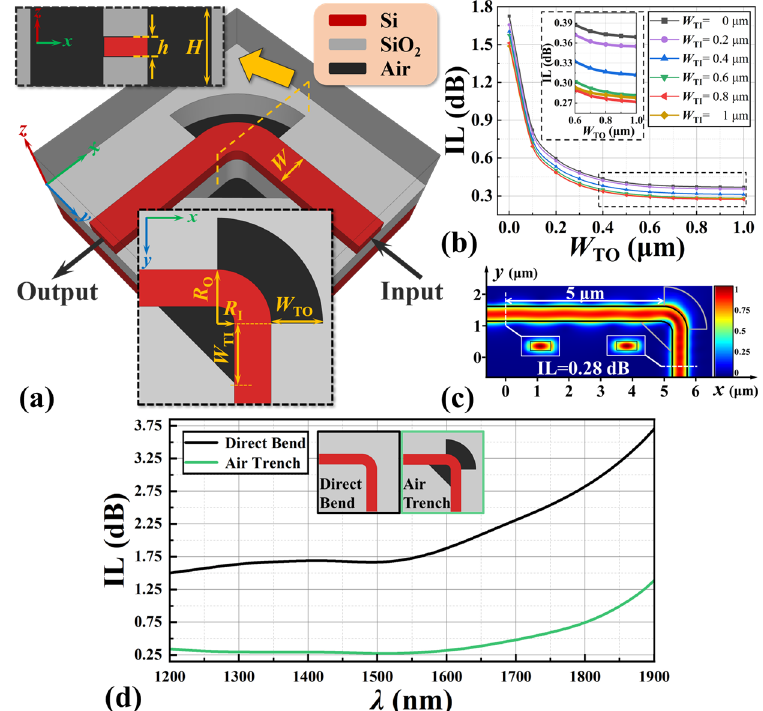
Figure 2. ( a ) Schematic of the silicon waveguide bend with two air trenches, where insets show the cross-section view and top view of the key bending region. ( b ) Device IL dependent on the air trench widths ( W TI , W TO ) of the waveguide bend. ( c ) Electric field evolution (| E |) through the proposed device, where | E | stands for the norm of electric field. ( d ) Wavelength spectrum of IL for the proposed waveguide bend compared with direct waveguide bend.